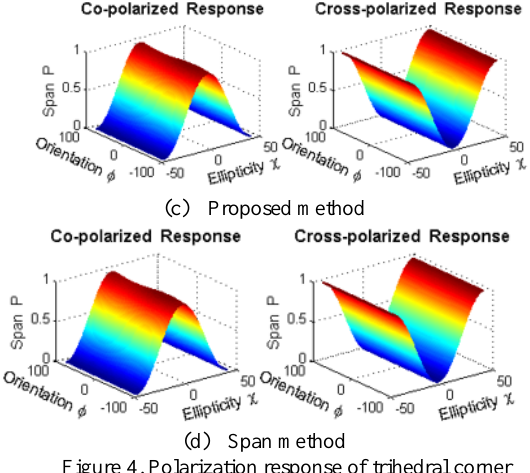
Figure 4. Polarization response of trihedral corner reflector.